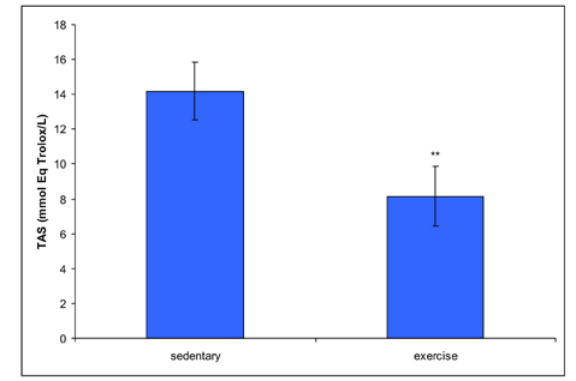
Figure 3. The effects of five minutes treadmill exercise on total antioxidant status (TAS) from the rat serum. The values are mean ± SEM (n=7 animals per group). **p=0.02 vs. sedentary-control group.